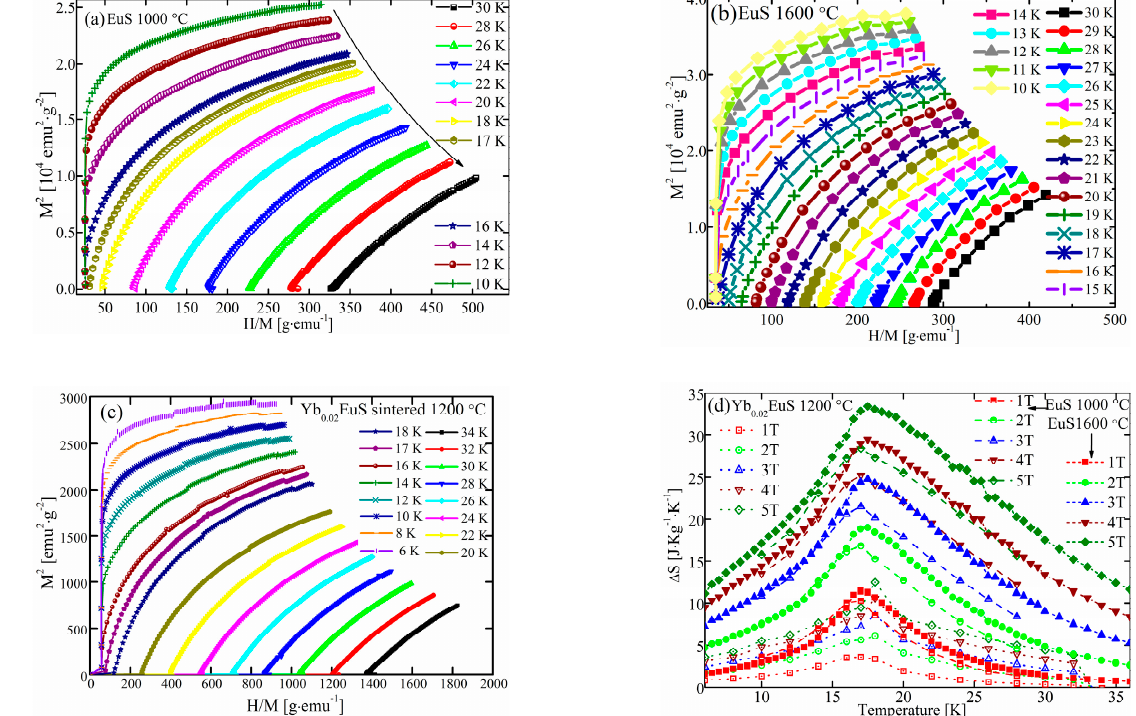
Figure 4. The Arrott plots (M 2 versus H/M) of polycrystalline undoped EuS sintered at 1000 ◦ C ( a ) and 1600 ◦ C ( b ); Yb-doped EuS ( c ); and the relationship between temperature and magnetic entropy variations of sintered EuS ( d ).